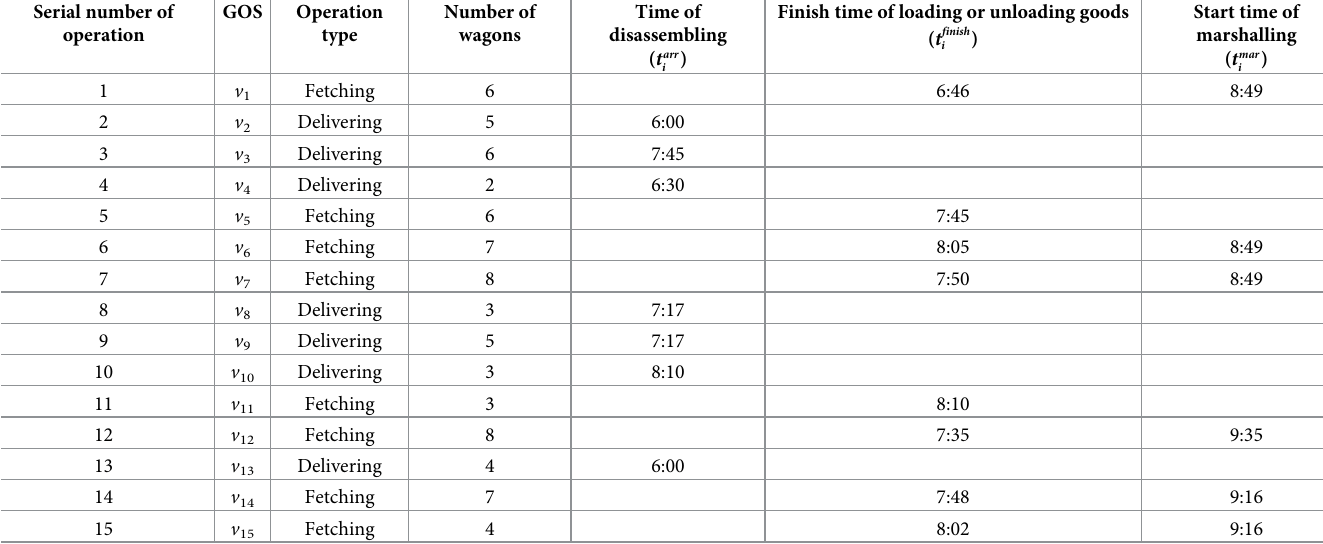
Table 3. Operation tasks of delivering and fetching wagons in the planning period of [6:00 am,10:00 am]. Serial number of operation